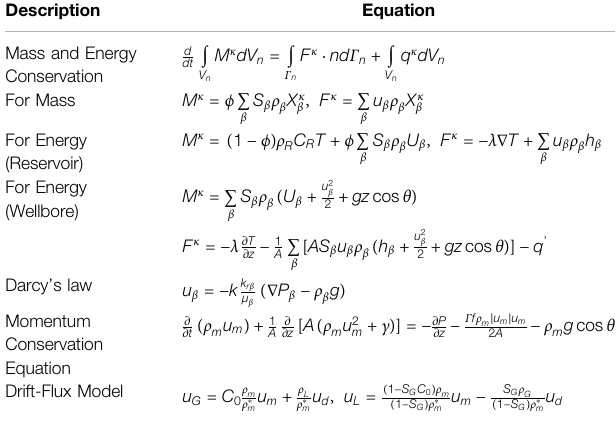
Frontiers in Earth Science |